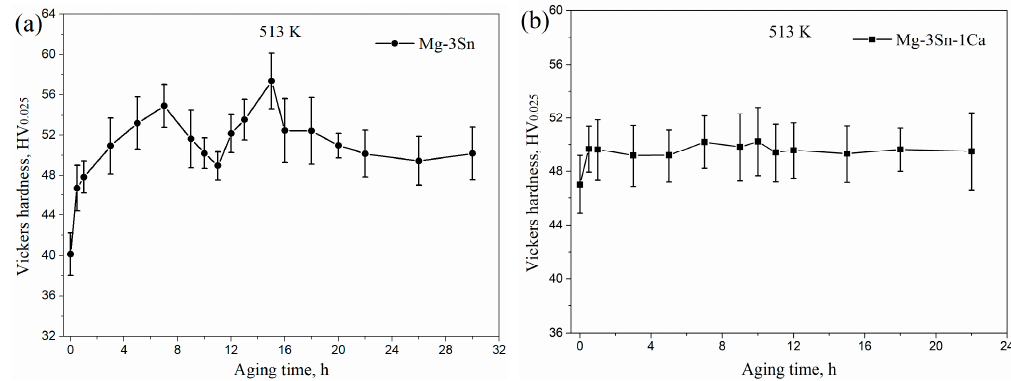
Figure 4. The microhardness of Mg-3Sn ( a ) and Mg-3Sn-1Ca ( b ) alloys with different aging times at 513 K.